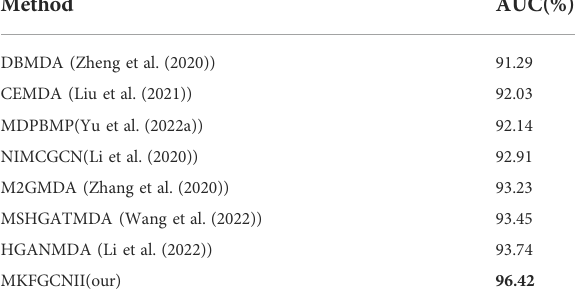
TABLE 3 The comparison results of MKFGCNII model with other latest models according to 5-fold cross-validation on HMDD v.2.0